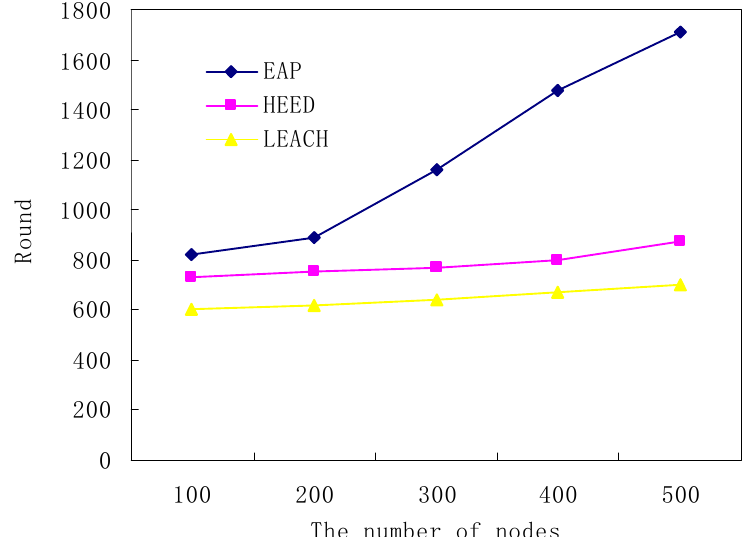
Figure 10. The number of nodes vs. network lifetime (expected QoS =